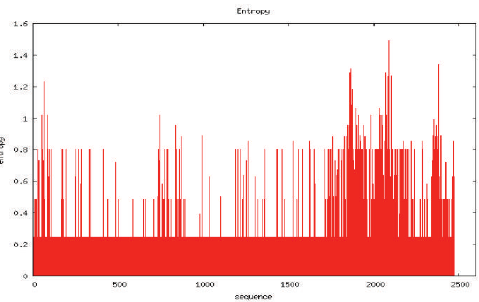
Figure 11: Diversity bar graph for each position.